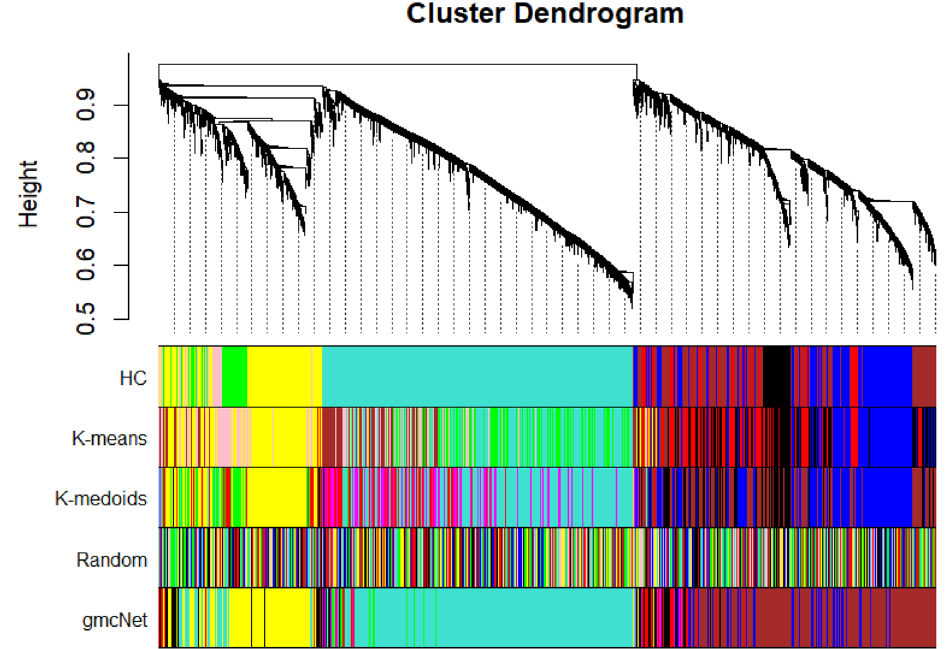
Figure 1. Module clustering results. The upper panel displays the hierarchical clustering dendrogram. In the lower panel, the colors show the module memberships determined by the methods on the